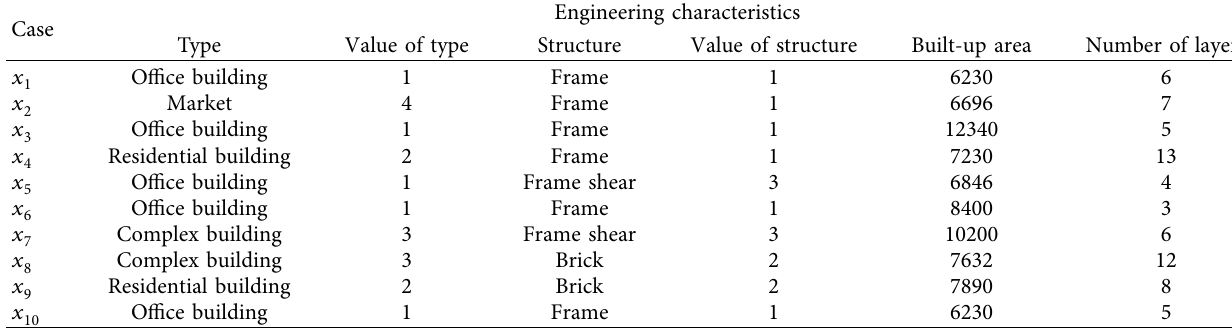
Table 3: Sample data of project case base.